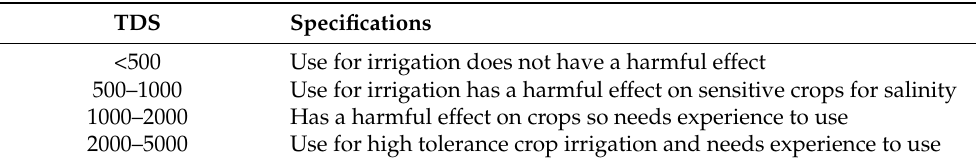
Table 2. Train classification for suitability of irrigation